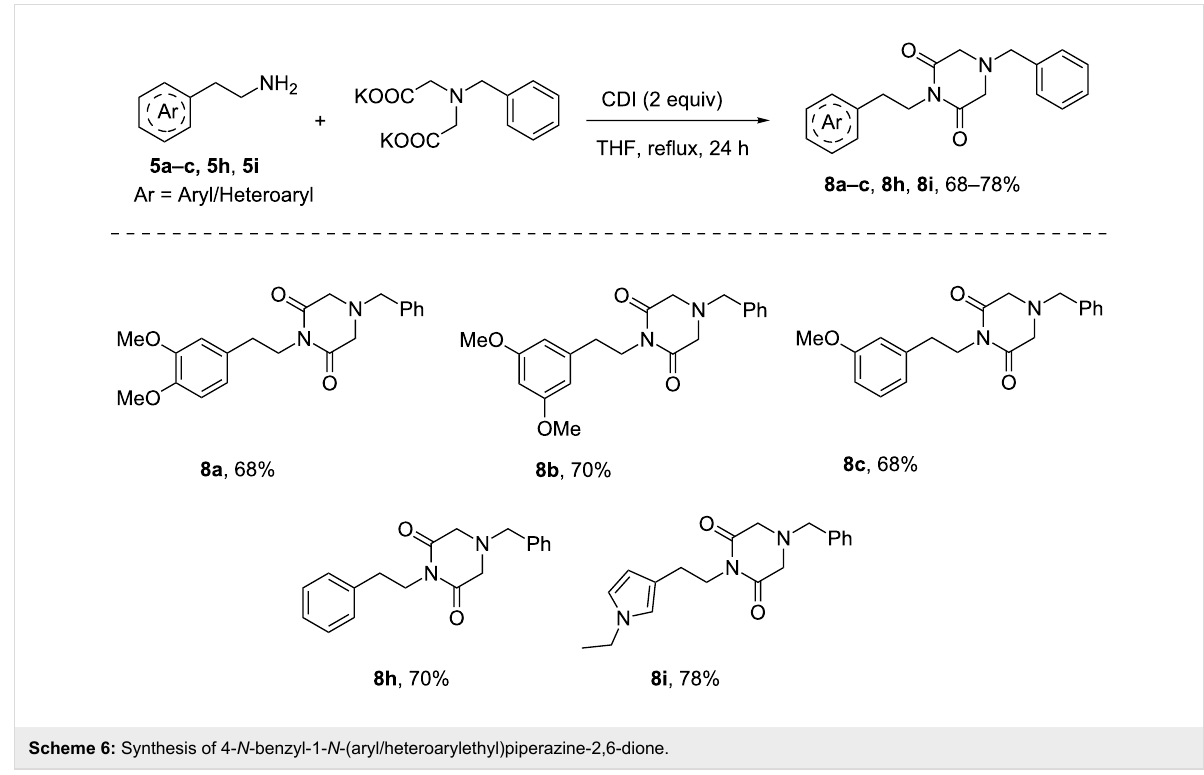
Scheme 6: Synthesis of 4- N -benzyl-1- N -(aryl/heteroarylethyl)piperazine-2,6-dione.